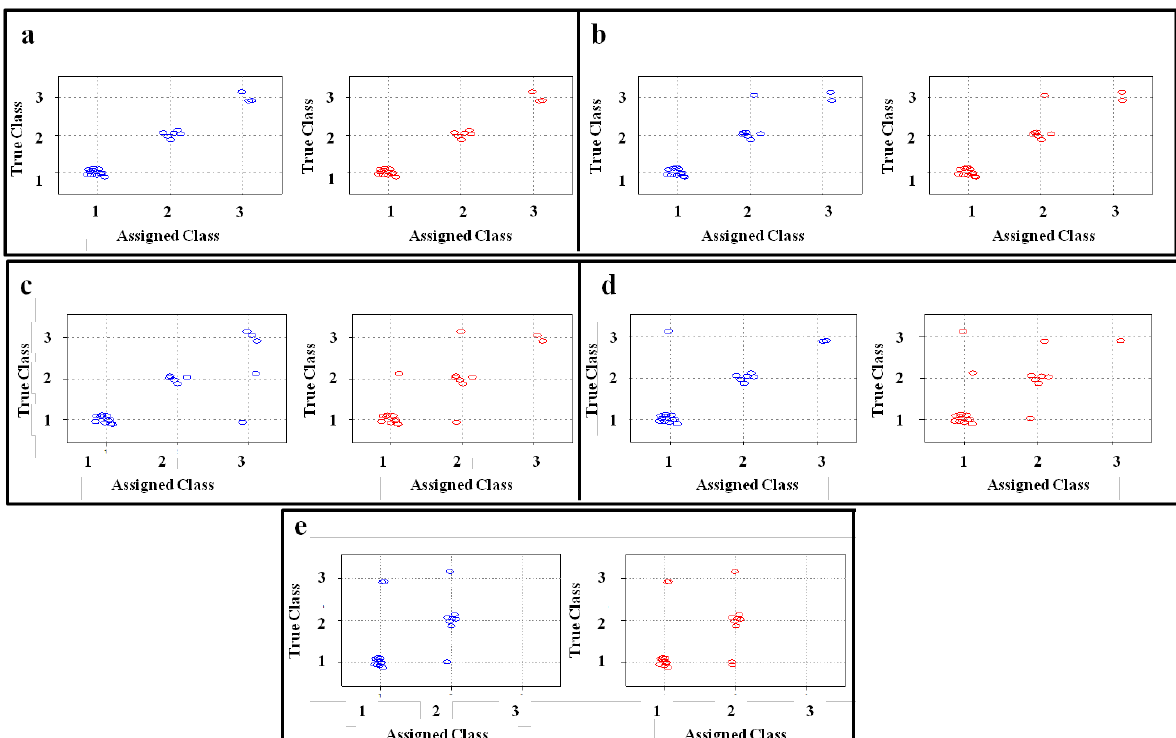
Figure 4. CART-model performance plots applied to each analytical protocol. Blue dots: samples classification in fitting; Red dots: samples classification in prediction by leave-one-out cross-validation). (a) protocol without the trapping device; (b) protocol with desorption at 180 °C; (c) protocol with desorption at 200 °C; (d) protocol with desorption at 220 °C; (e) protocol with desorption at 240